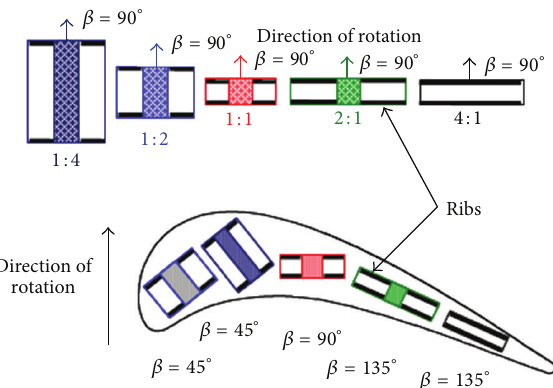
Figure 28: Examples of various channel orientations and aspect ratios employed for internal cooling of turbine blades from Fu et al.